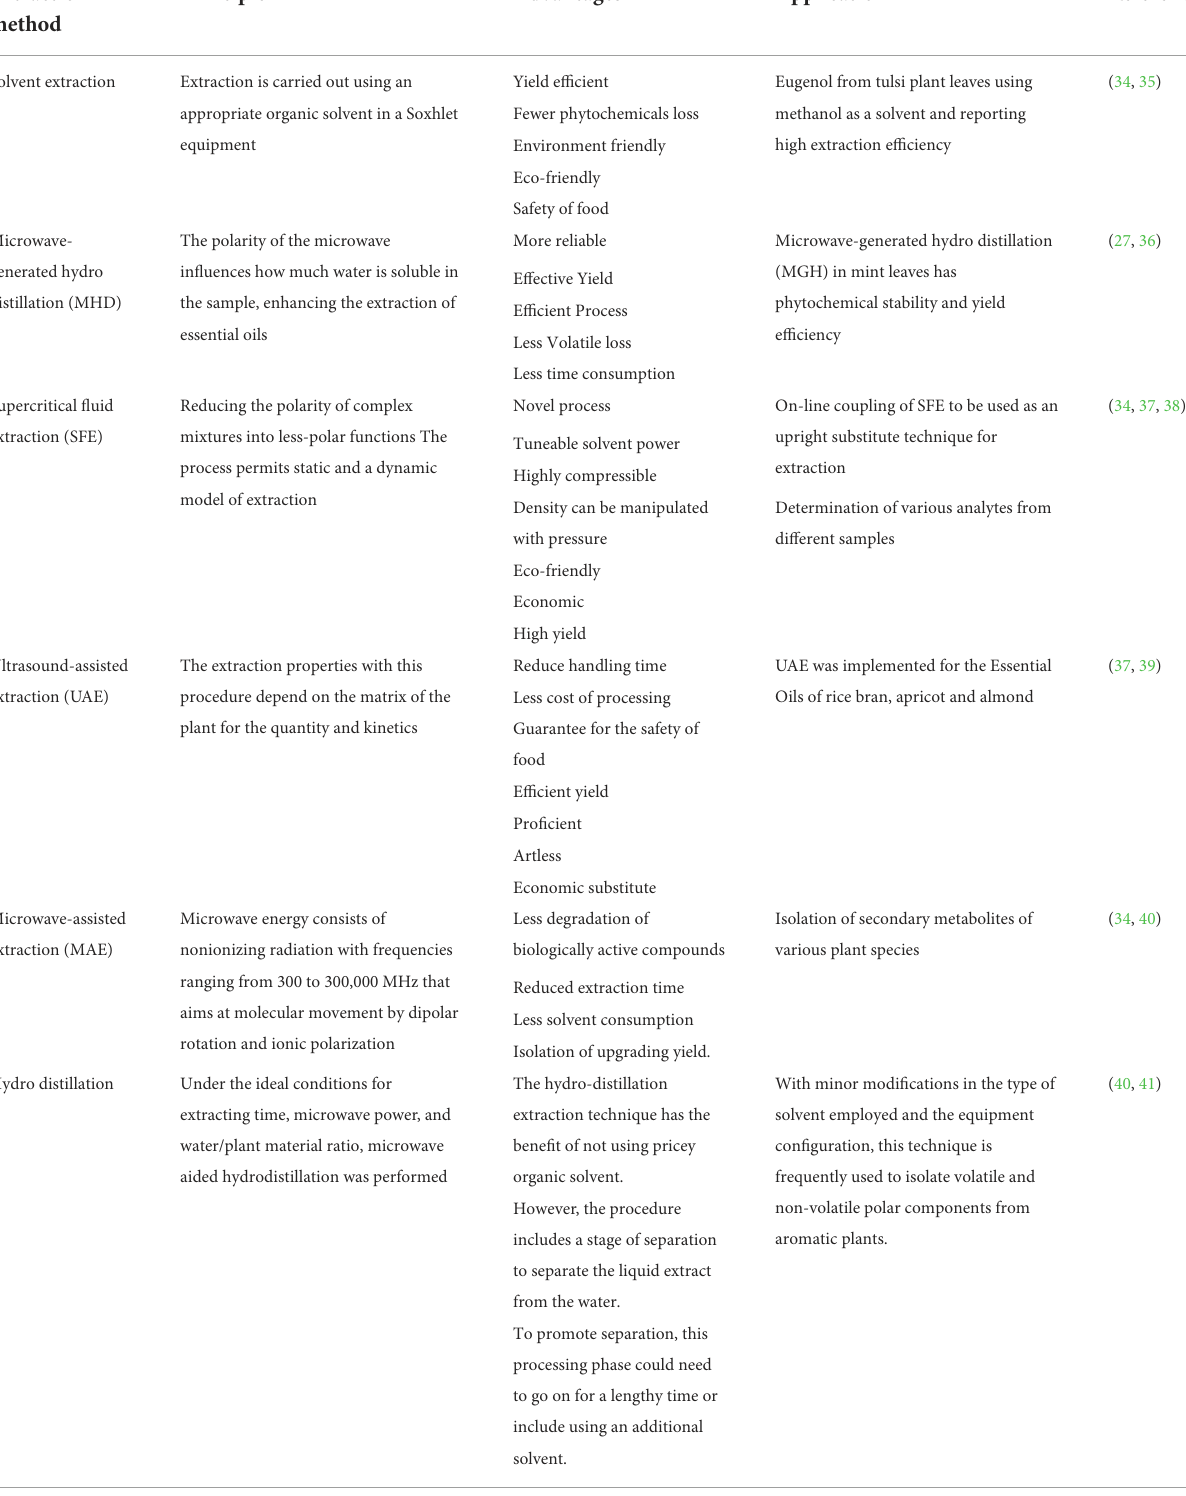
TABLE 1 Various extraction methods of clove essential